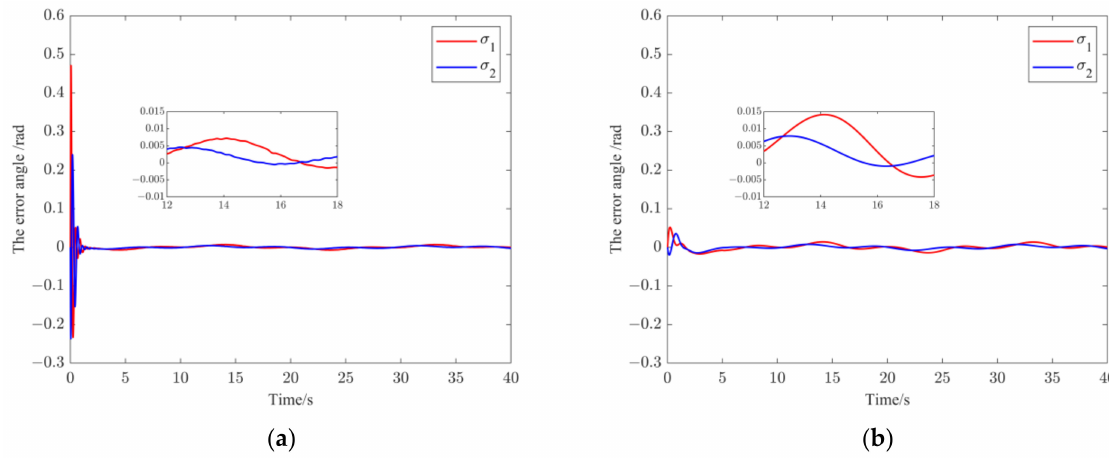
Figure 18. The angle error σ . ( a ) RBFTHC, ( b )